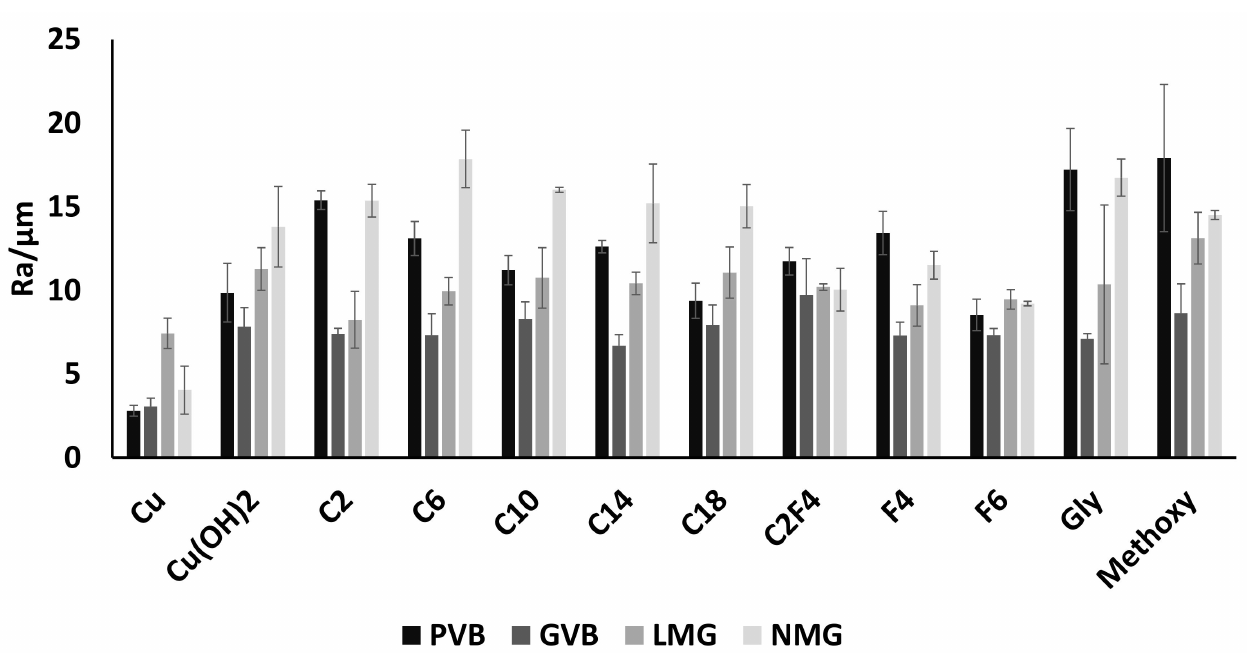
Figure 5. Roughness measurements for printed surfaces for all raw or functionalized surfaces (From dark to clear: PVB, GVB, LMG and